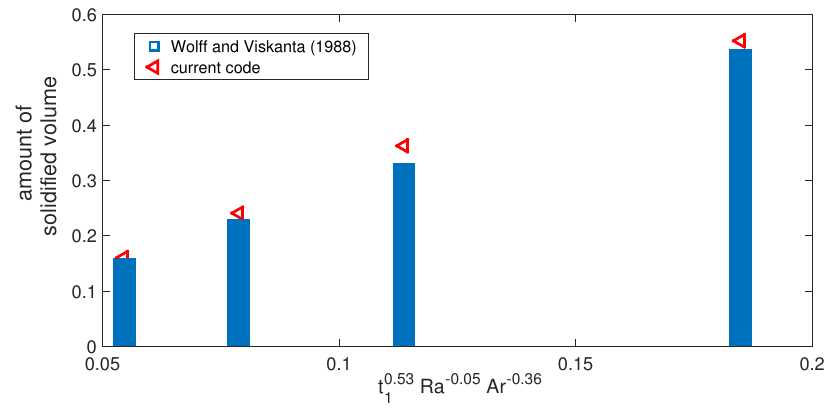
Figure 5. Code validation 2: comparisons of the solidified volume fraction for PC dynamics in a differentially heated cavity. Results presented in [56] were